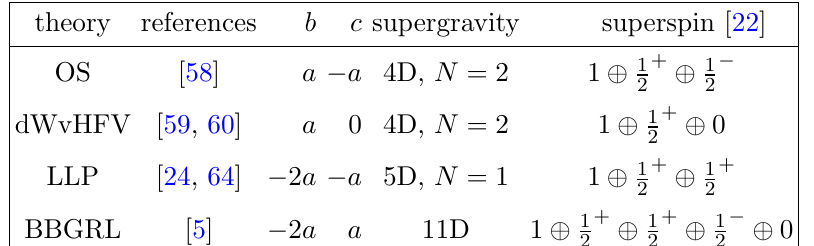
(C.18) this ( a;b;c )